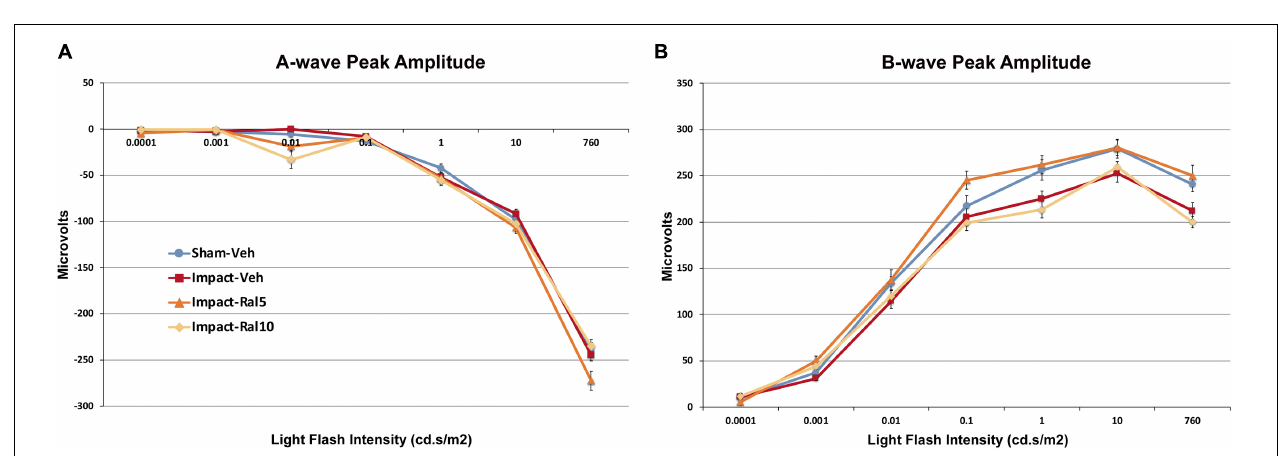
FIGURE 2 | Average flash-evoked scotopic ERG peak A-wave and B-wave amplitudes at ∼ 2 months after impact. (A) A-wave peak amplitudes, compared across the three brightest light intensities, were similar for sham-vehicle, impact-vehicle, and impact-ral10 mice, but were increased for the impact-ral5 mice ( p = 0.0006 relative to sham). (B) B-wave peak amplitudes, compared across the six brightest light intensities, were reduced for impact-vehicle mice ( p = 2.8 × 10 − 5 relative to sham). Impact mice treated with 5 mg/kg raloxifene showed rescue of the B-wave deficit, with amplitudes increased compared to impact-vehicle mice ( p = 2.0 × 10 − 10 ). Raloxifene at 10 mg/ml did not yield rescue, with B-wave amplitudes similar to impact-vehicle mice and significantly less than in sham ( p = 3.2 × 10 − 5 ). Errors bars are SEMs. Animal numbers: 15 sham-vehicle mice, 17 impact-vehicle mice, 17 impact-ral5 mice, and 14 impact-ral10 mice.